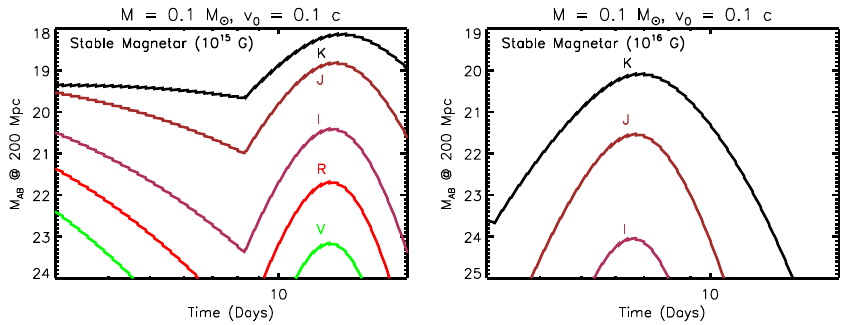
Fig. 10 Kilonova light curves, boosted by spin-down energy from an indefinitely stable magnetar ( t collapse = ∞ ). We assume an ejecta mass M = 0 . 1 M (cid:4) (Metzger and Fernández 2014), initial mag- netar spin period P